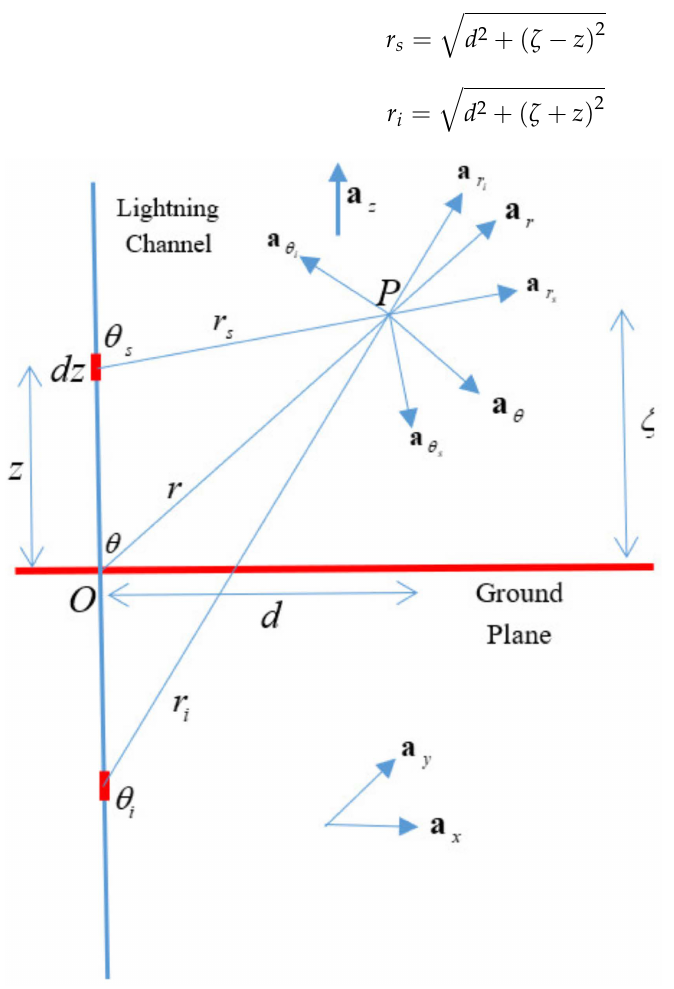
Figure 1. Geometry relevant to the parameters used to describe the electric